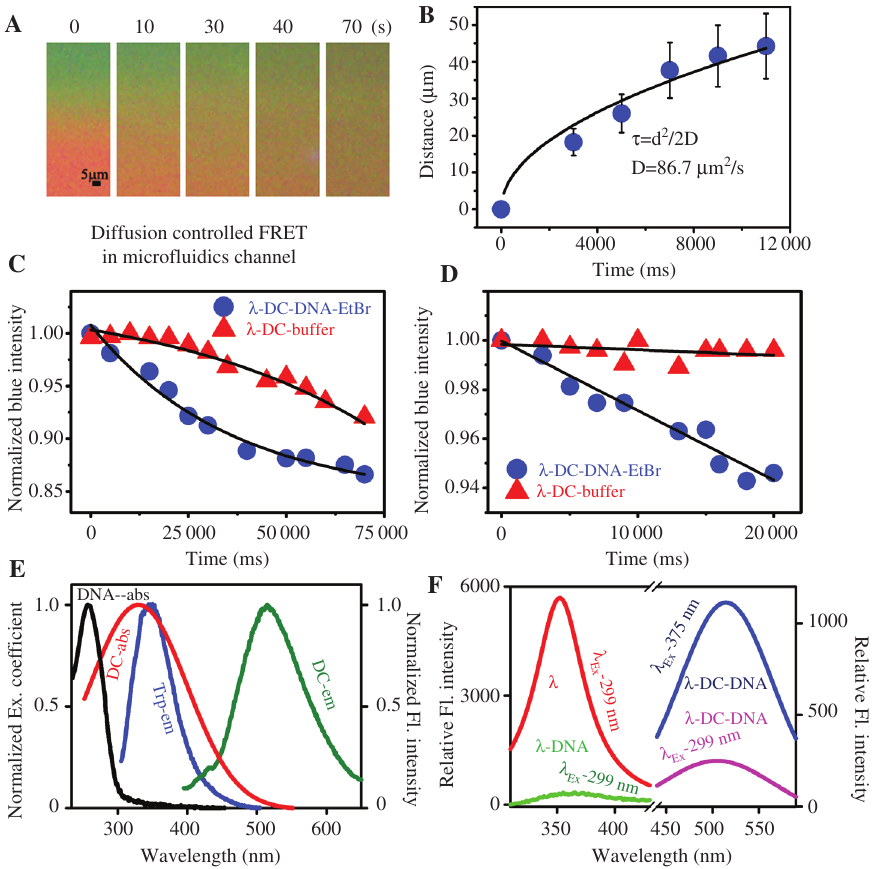
(nm)0.90 Figure 19 Diffusion-controlled FRET in microfluidics channel. (A) Fluorescence microscopic images of dansylated λ -repressor-O 1 DNA-EtBr complex at a fixed position of microfluidics channel in dif- R ferent time window. (B) Diffusion of the biomolecule (dansylated λ -repressor) under study. (C) Change in normalized blue intensity of dan- sylated λ -repressor in buffer ( λ -DC-buffer; red) and dansylated λ -repressor-O 1 DNA-EtBr complex ( λ -DC-DNA-EtBr) with time (up to 70 s). R (D) Same as described in (C) within a smaller time window (20 s). (E) The steady-state absorption spectra of DNA (DNA-abs; black), Dansyl (DC-abs; red), and emission spectra of tryptophan in λ -repressor (Trp-em; blue), dansyl bound to λ -repressor (DC-em; green) are shown. (F) Steady-state fluorescence spectra of tryptophan in λ -repressor ( λ ; red) and in λ -repressor-O 1 DNA complex ( λ -DNA; green). Systems are R excited at 299 nm. Steady-state fluorescence spectra of dansyl in λ -repressor-O 1 DNA complex at excitation wavelength 375 nm ( λ -DC-DNA; R blue) and 299 nm ( λ -DC-DNA; pink) are shown. [Reprinted with permission from ref. (27) Copyright 2012, Taylor &